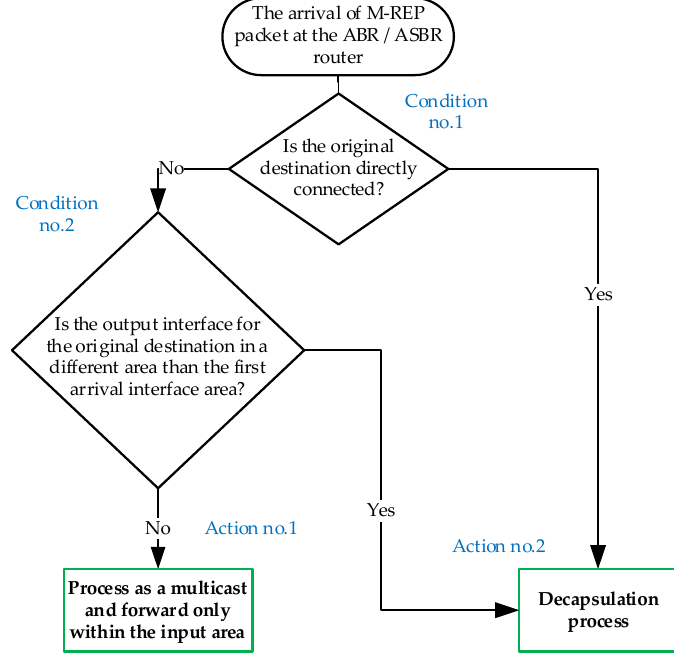
Figure 10. The Area Border Router (ABR) router behavior after the arrival of M-REP packet. Sensors 2020 , 20